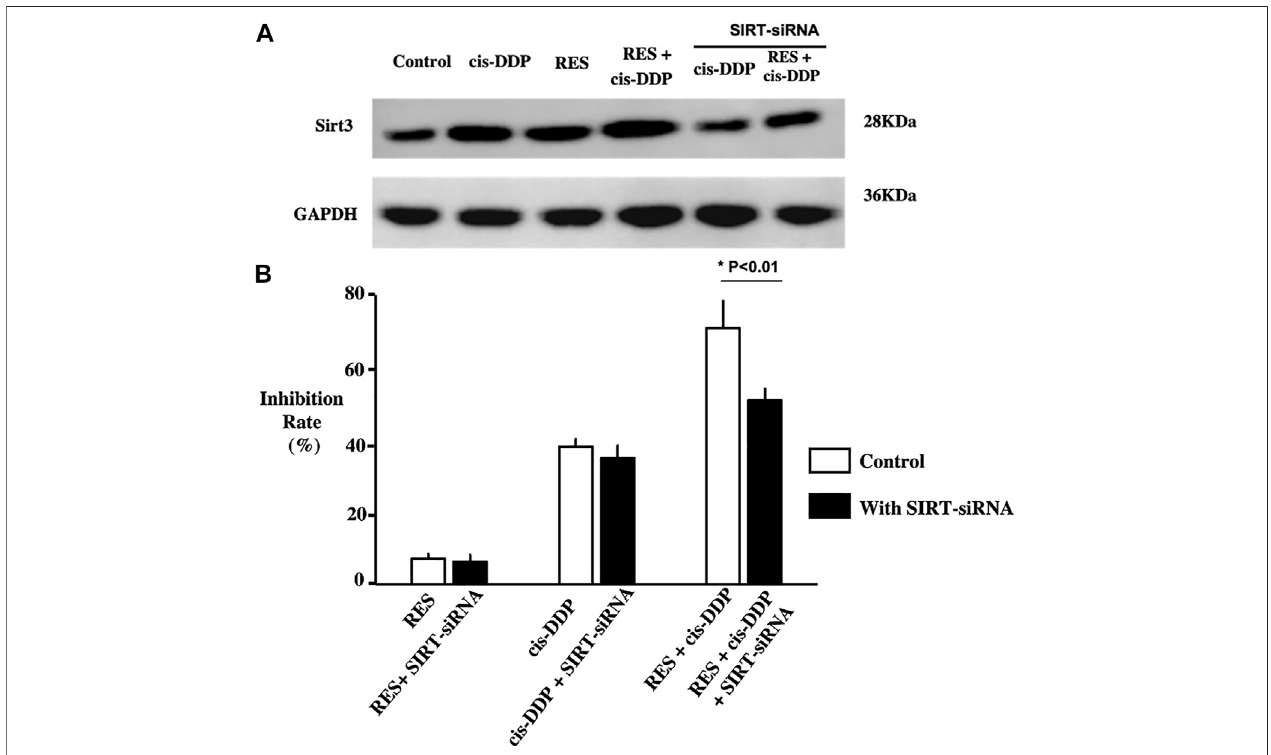
FIGURE3| Rescombined withcis-DPP enhanced theexpression ofSIRT3;silencingofSIRT3 compromised Res+cis-DPP – inducedSiHainhibition. (A) Western blotting of the SIRT3 expression in each group showed that RES + cis-DPP signi fi cantly enhanced the SIRT3 expression compared with other groups ( p < 0.05). (B) Normalized growth rate inhibition of the RES alone, cis-DDP alone, and RES + cis-DDP groups, with or without silencing of SIRT3. It showed that SIRT3 RNA silencing signi fi cantly compromised the SiHa growth inhibition rate only in the RES + cis-DDP group ( p <